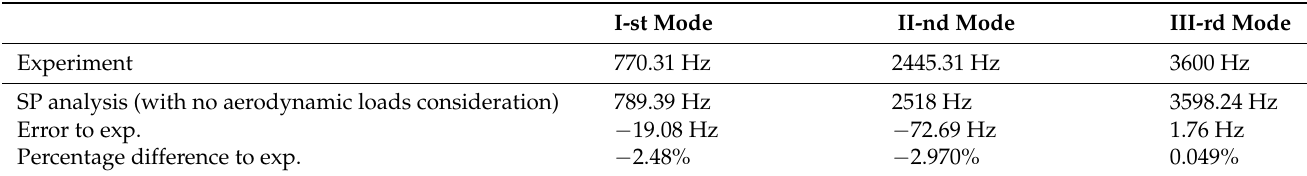
Table 6. List of resonant frequencies of an axial compressor blade of a turbine engine, estimated numerically and